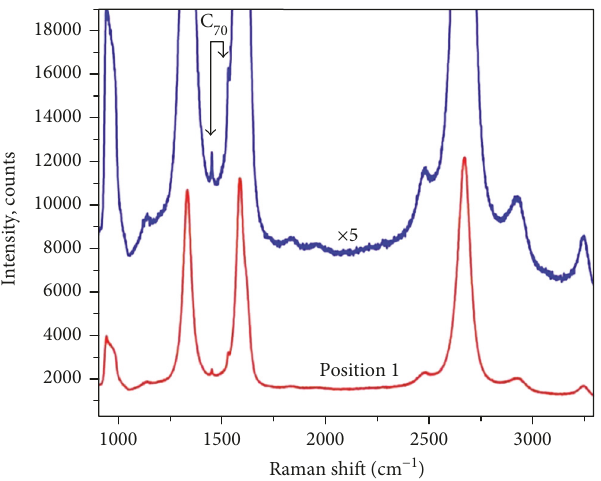
Figure 7: The Raman spectra of as-grown graphene on α C excited at 488 nm (green trace) and 633 nm (black trace) wavelengths. The similar spectra of exfoliated graphene transferred on a glass fullerenes. 70 substrate excited at 488 nm (blue trace) and 633 nm (red trace). The inset: magni fi ed part of the region 900 – 1200cm − 1 .